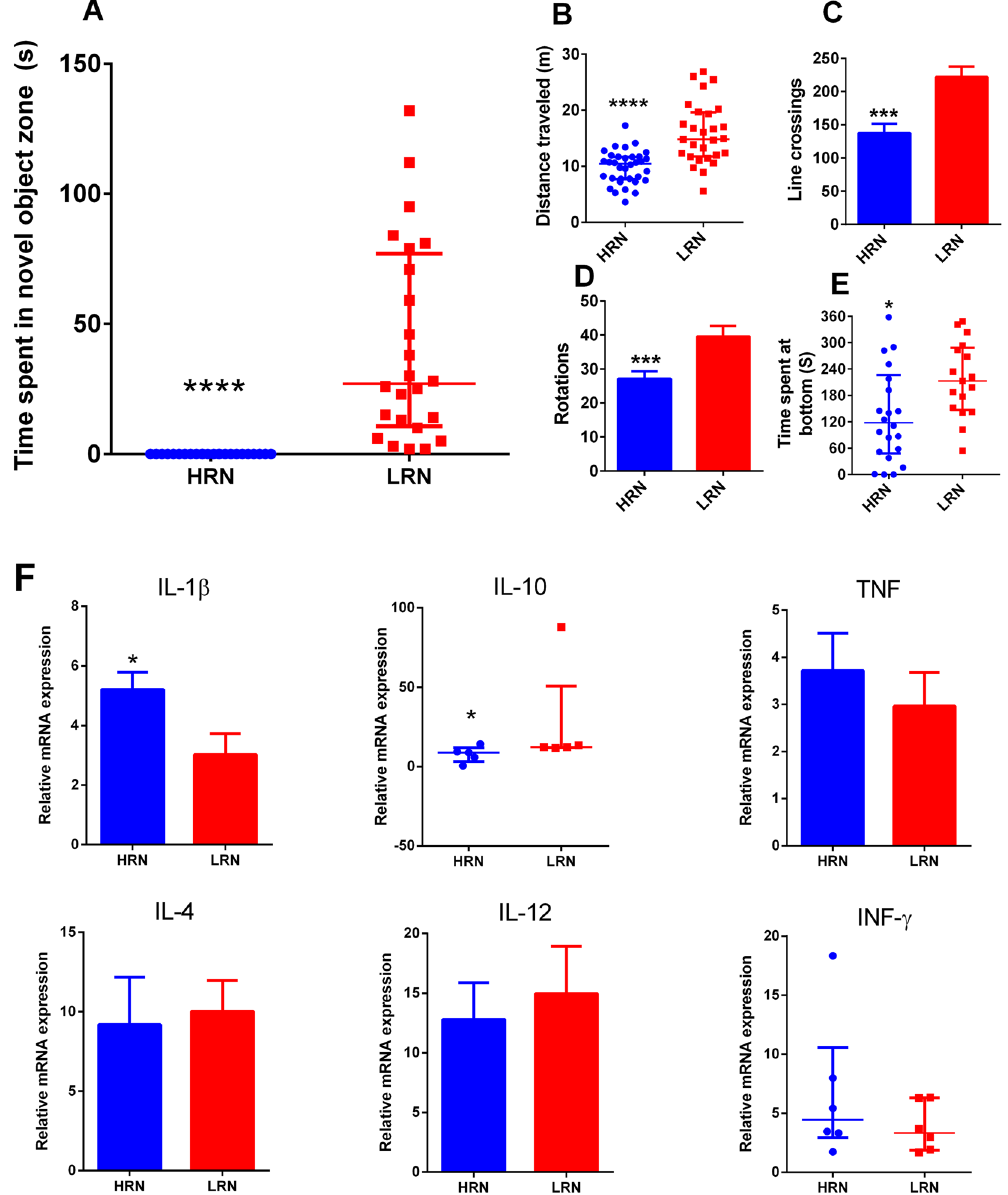
Figure 1. Novel object test. Time spent in the novel object zone ( A ), distance traveled ( B ), line crossings ( C ), rotations ( D ), time spent at the bottom ( E ) and expression of cytokine genes ( F ). Each data represents the mean ± SEM or median ± interquartile range, depending on the data normality assessed by the Bartlett’s test. In panels A to E data represents the mean or median of 24 fish. In panel F, data represents the mean or median of 6 pooled samples. Significant differences are indicated by asterisk ( * p < 0.05; **** p <